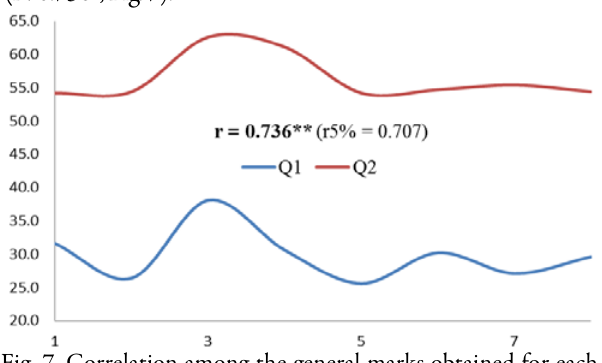
Fig. 7. Correlation among the general marks obtained for each apple cultivar on Questionnaires 1 and 2, with different scales of tasting